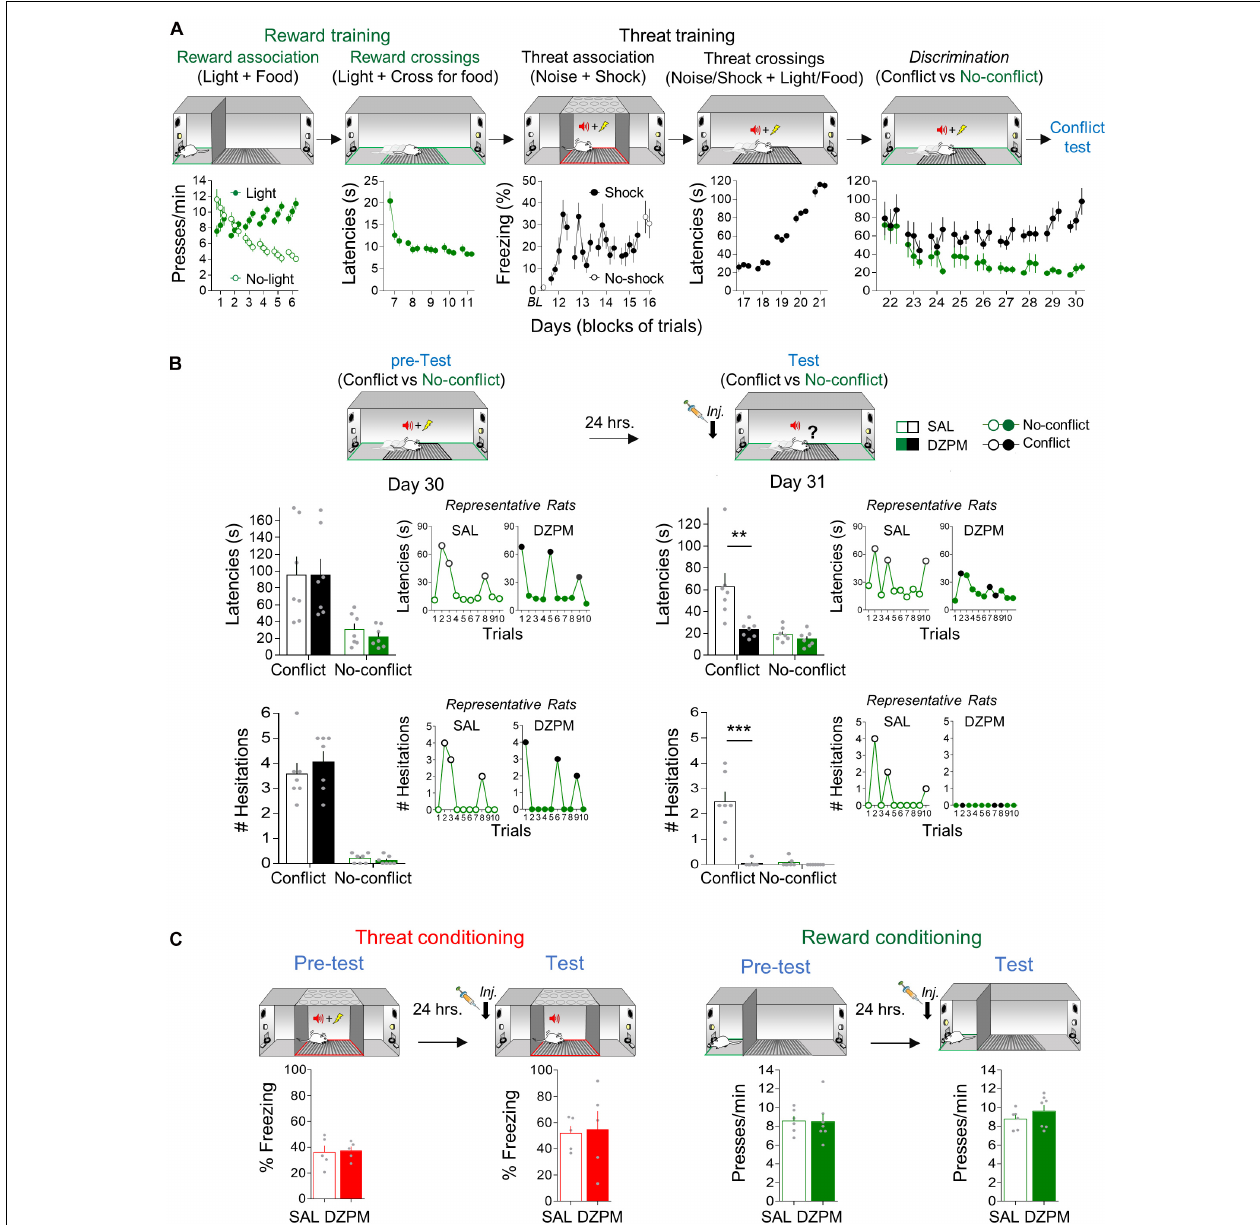
FIGURE 2 | Diazepam decreases crossing latencies and hesitation events during conflict without affecting no-conflict trials. (A) Rats acquired crossing-mediated conflict in 30 days ( n = 14). First, hungry rats, confined to the safe zone (green), learned to associate pressing a lever with food availability cued by a light (reward conditioning), followed by training to cross to the opposite safe zone of the straight alley to obtain food cued by light (no-conflict crossings). Then, rats, confined to the threat zone (grid, red) of the alley, learned to associate the occurrence of white noise with a mild footshock (threat conditioning), followed by training to cross with both learned contingencies (light/food and noise/shock) presented simultaneously (conflict crossings). Finally, rats were trained to discriminate crossing trials guided by no-conflict (light/food alone) or conflict (light/food and noise/shock) cues. Data from lever pressing (per minute) and time to cross to the opposite safe zone of the alley (latency in seconds) are presented in blocks of three trials per day, whereas percent time spent freezing (with or without shock) is presented for each trial. By the end of crossing-mediated conflict training, rats showed high crossing latencies during conflict trials (black) compared to no-conflict trials (green). (B) Before injection (pre-test), saline solution and diazepam groups (SAL, n = 7; DZPM, n = 7) showed similarly high crossing latencies (top) and hesitation events toward the reward site (bottom) during Conflict trials and similarly low crossing latencies and hesitations events during No-conflict ( left , trials averages of experimental groups; right , trial by trial performance of representative rats). The following day, after injection (test), the diazepam-treated rats decreased crossing latencies (top) and hesitation events (bottom) during conflict trials (no shock) while leaving no-conflict trials intact, as compared to the saline-treated rats ( left , trial averages of experimental groups; right , trial by trial performance of the same representative rats shown in pretest). (C) Rats were separately trained in threat and reward conditioning tasks. Before (pre-test) and after (test) injection, SAL and DZPM groups (SAL, n = 5; DZPM, n = 5) showed similar reactive freezing responses during aversive conditioning and numbers of lever presses per minute during appetitive conditioning (SAL, n = 6; DZPM, n = 7). Error bars indicate Standard Error of Mean (SEM). BL, baseline. ** p < 0.01; *** p < 0.001.